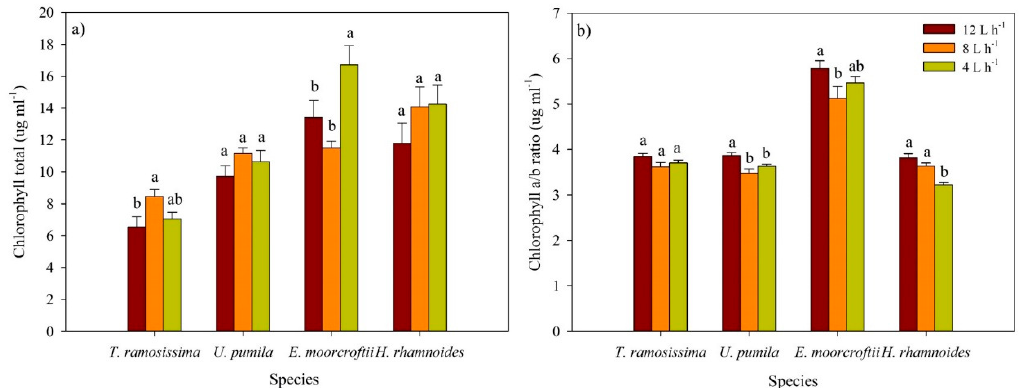
Figure 8. ( a ) Total chlorophyll content and ( b ) chlorophyll a/b ratio of Tamarix ramosissima , Ulmus pumila , Elaeagnus moorcroftii , and Hippophae rhamnoides across different irrigation treatments (12, 8, 4 L h − 1 ) measured in July 2016. Different lowercase letters within each species indicate significant differences among the treatments at α = 0.05. Vertical bars represent standard errors.